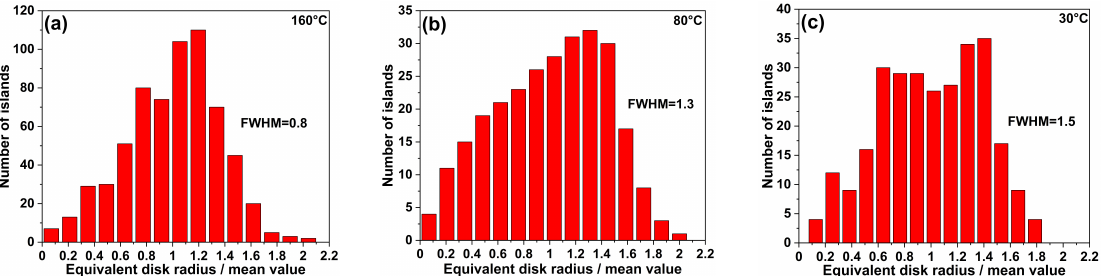
Figure 5. Size distributions of indium islands normalized to their mean size at ( a ) 160 ◦ C, ( b ) 80 ◦ C, and ( c ) 30 ◦ C calculated from 1 × 1 µ m 2 AFM scans of each sample. The mean equivalent disk radius for panel ( a ) is 8.5 ± 3.0 nm, for panel ( b ) is 9.7 ± 4.1 nm, and for panel ( c ) is 10.6 ± 4.1